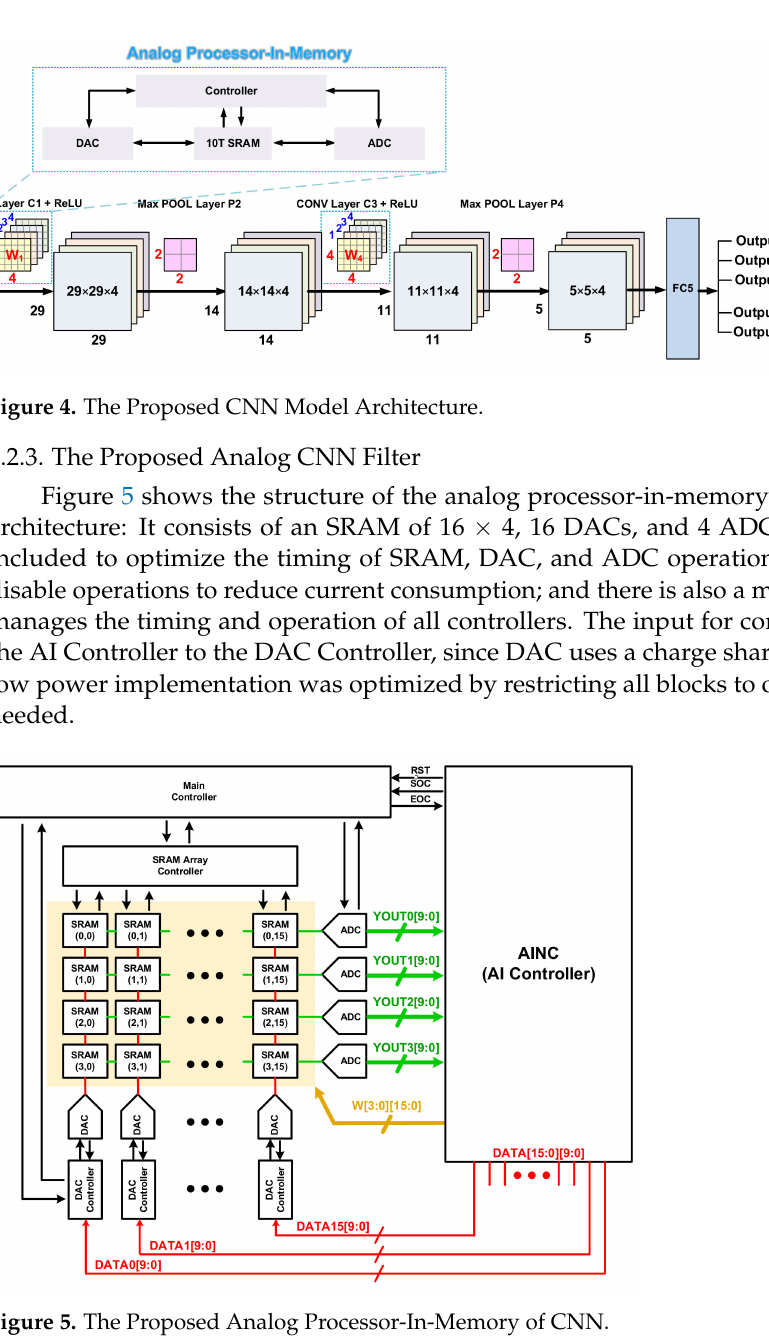
Figure 5. The Proposed Analog Processor-In-Memory of